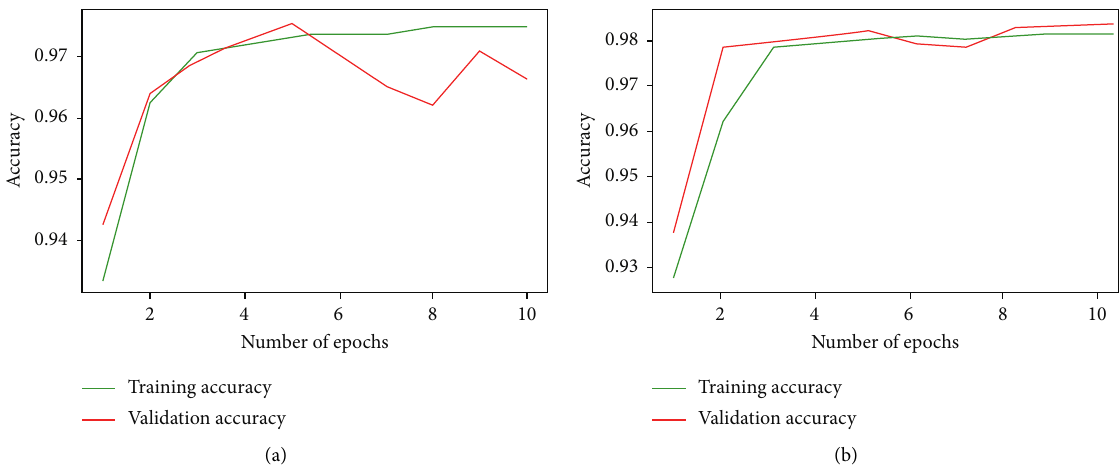
Figure 14: Performance of the proposed models: (a) convolution neural network (CNN) model and (b) long short-term memory (LSTM)